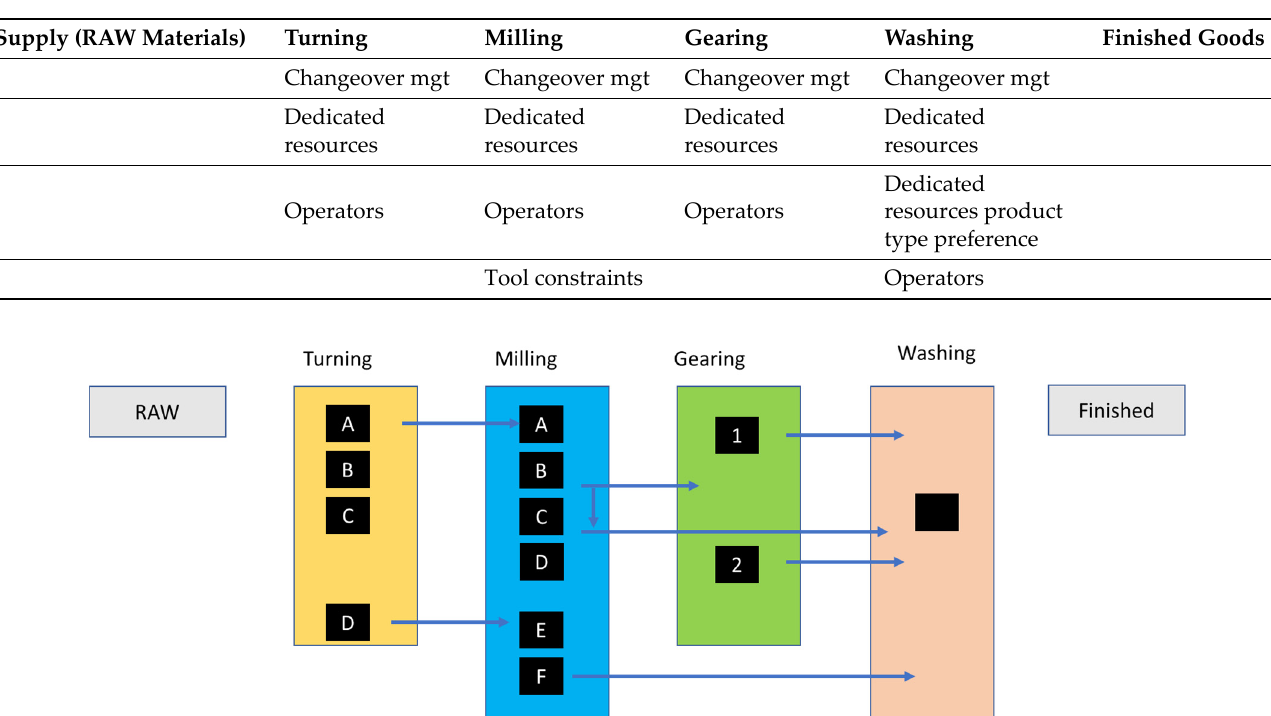
Table 2. Constrains model to create model for scheduling.